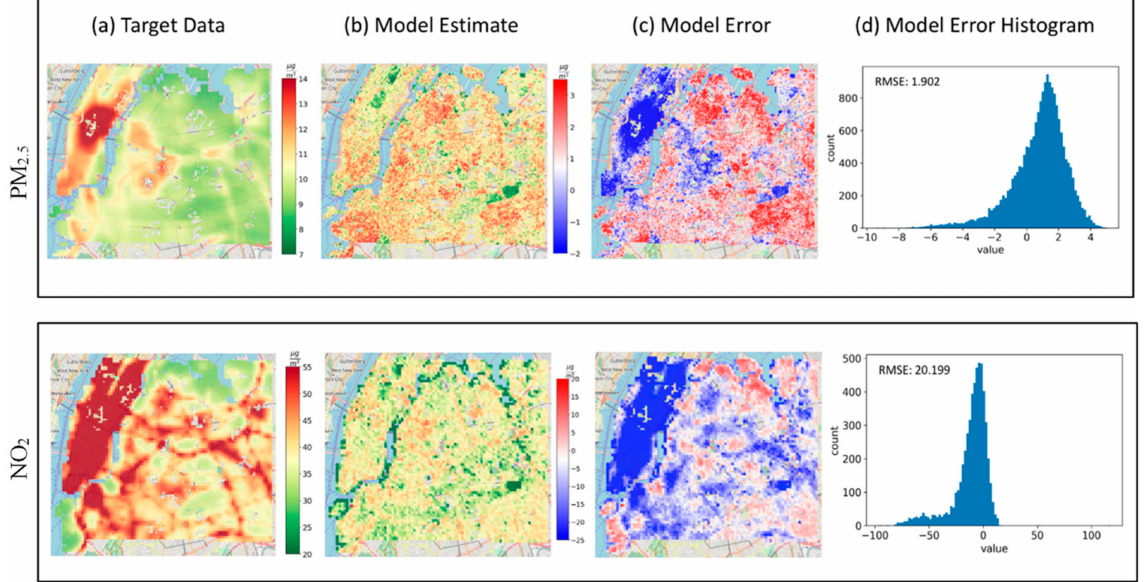
Figure 4. PM 2.5 and NO 2 target data, model estimates and errors for NYC. Target data ( a ), based on 2010 LUR data in New York City. Column ( b ) shows the 100 m, and 200 m model estimates of PM 2.5 and NO 2 annual concentrations, respectively. Column ( c ) shows the model residuals calculated by the difference between the predicted concentrations and the target data, and the residuals’ distributions are shown in column ( d